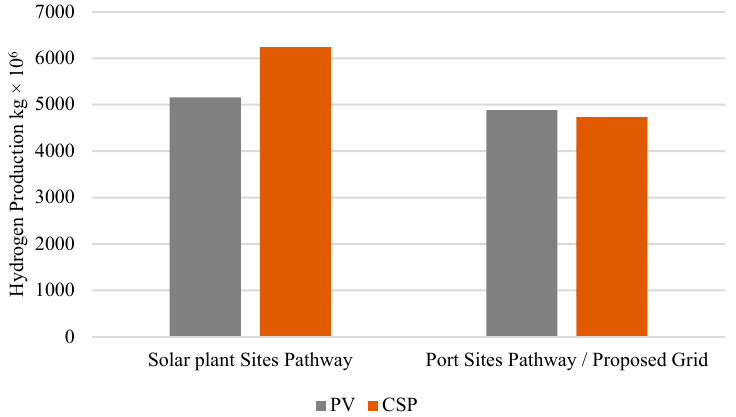
Figure 13. Comparison between the amounts of produced H 2 in the two location pathways with new proposed routes.